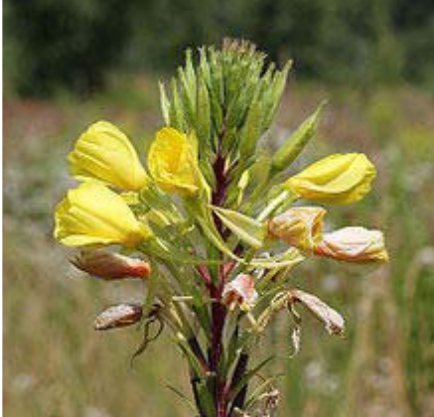
Fig. 1. Image of Oenothera Fig.1 Image of Oenothera biennis